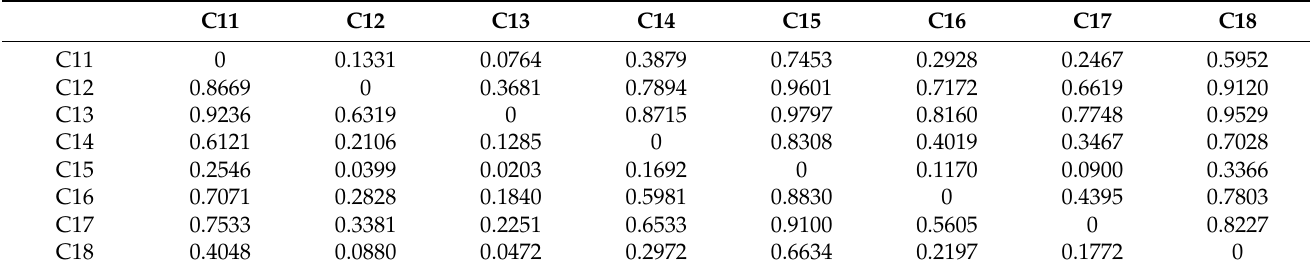
Table 3. Confidence value between eight decision criteria in the carrier selection